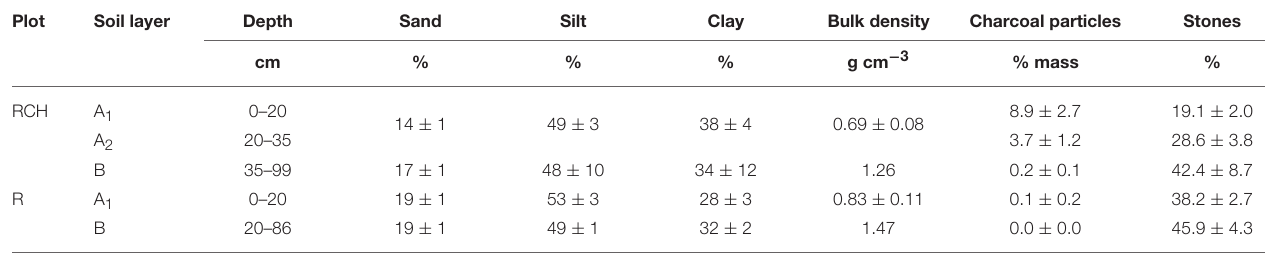
TABLE 1 | Physical properties of the relic charcoal hearths (RCHs) and the reference (R) soils. Plot Soil layer Depth Sand Silt Clay Bulk density Charcoal particles Stones cm % % % g cm − 3 %